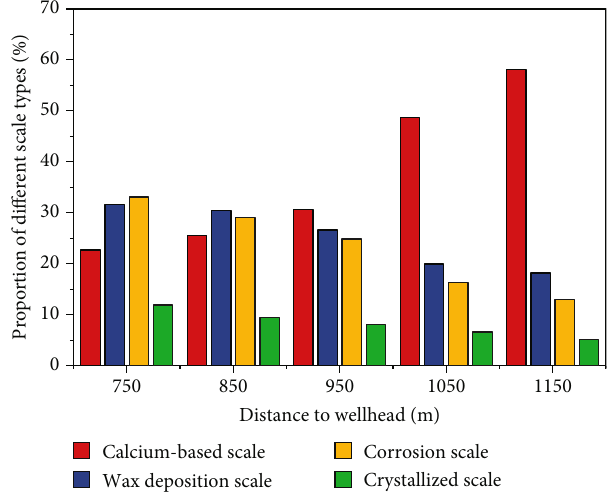
Figure 9: Distribution of scale types for Chang 8 payzone.